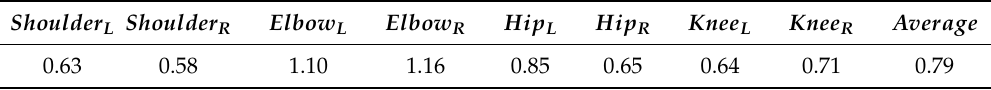
Table 2. The average error in angle estimation (in degrees) at predicted joint locations with respect to corresponding ground truth. The subscripts R and L represents the right and the left body part,